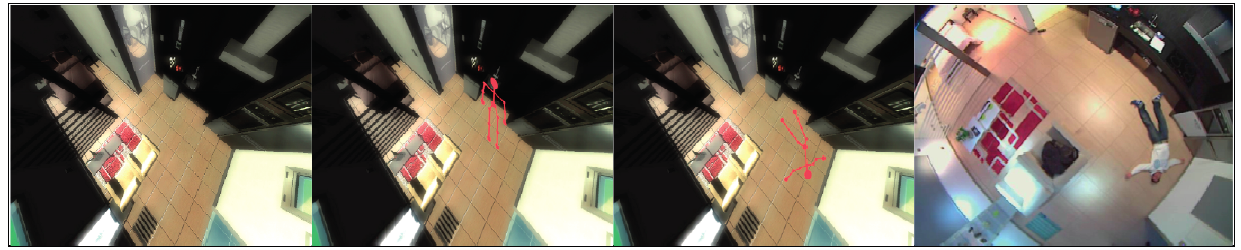
Figure 8. Real images at MetalTIC of integrated privacy levels: scenario with no people, including position, adding gesture to position and the original